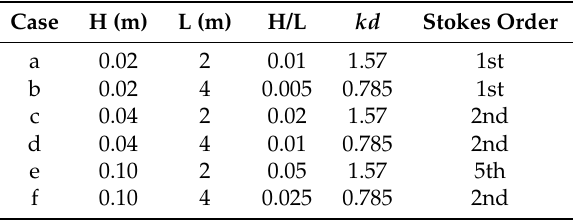
Table 1. Tested wave